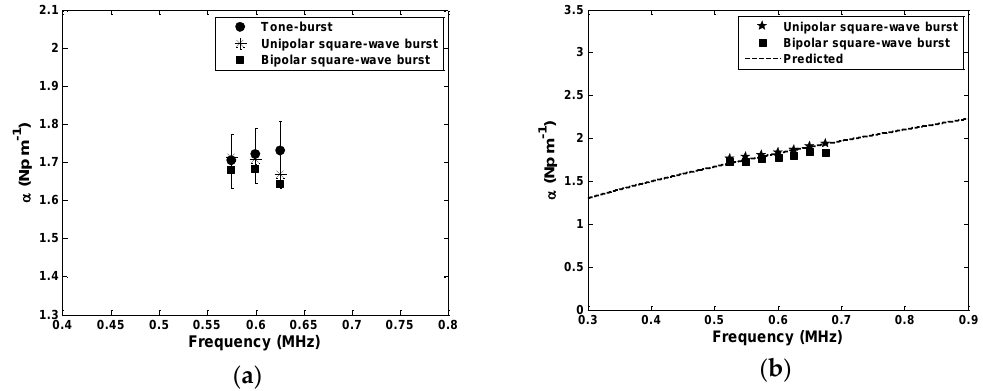
Figure 4. Attenuation measurements for the T(0,1) mode for 1mm diameter carbon steel rod immersed in olive oil ( a ) using tone-burst, unipolar square wave burst, and bipolar square wave burst as excitation signals. Average values of five recordings are shown as symbols. Solid error bars represent the standard deviation of the measurements using the tone-burst; ( b ) using unipolar and bipolar square wave bursts as excitation along with predicted values.